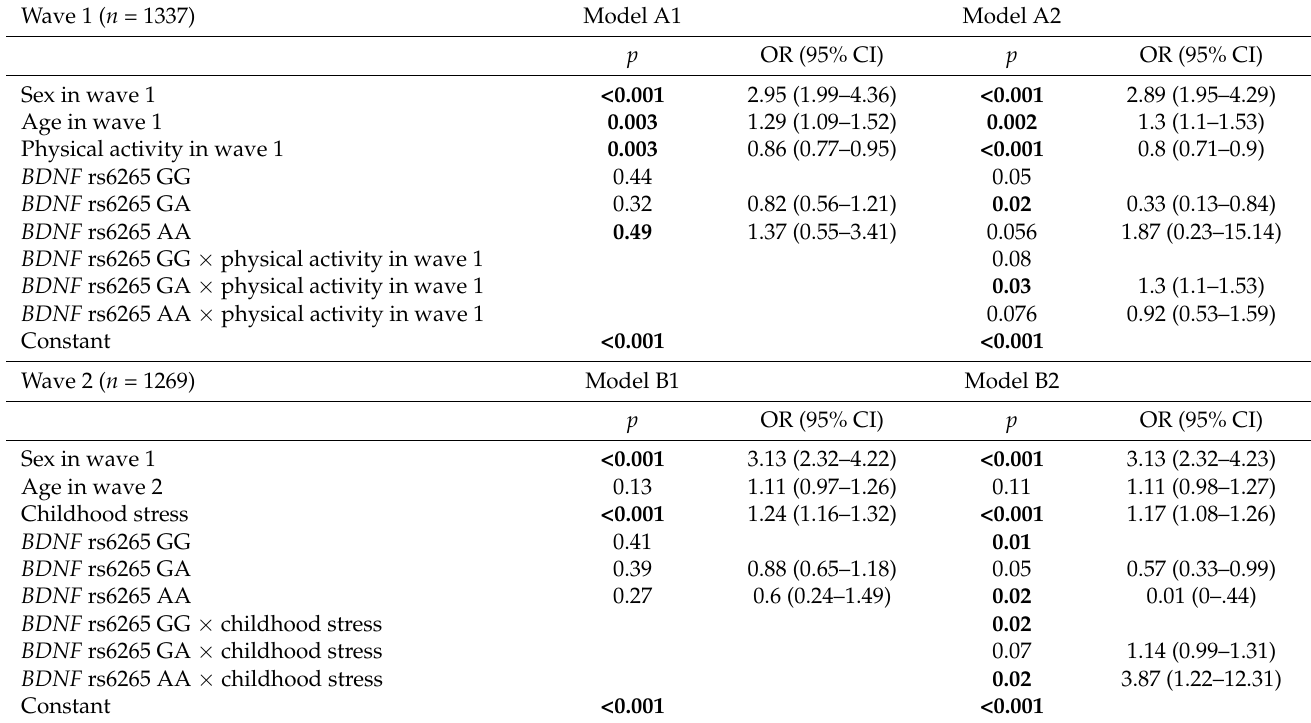
Table 2. Binary logistic regressions used to analyse the relationship between showing depressive symptoms and sex, age, and BDNF rs6265 variants and physical activity or childhood